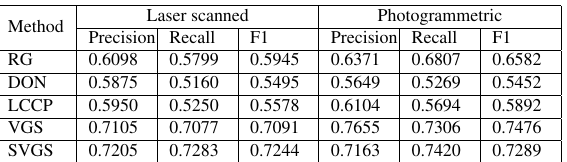
Table 2. Evaluation results of the construction site dataset